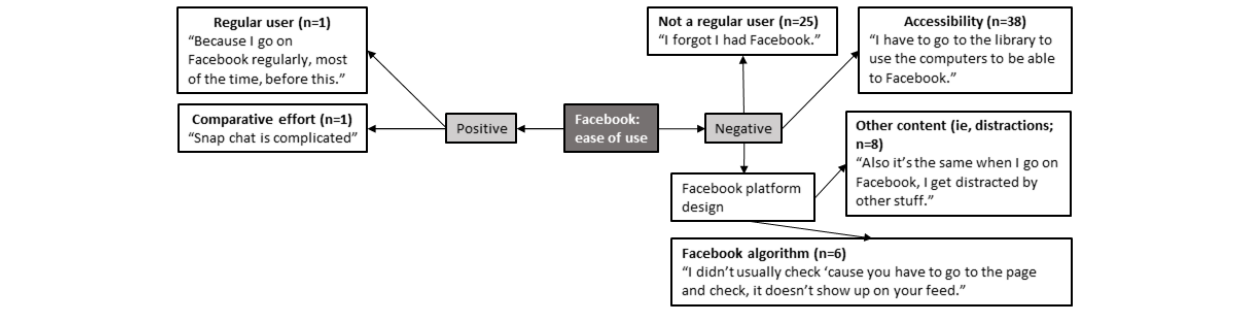
Figure 5. Perceived ease of use of Facebook in adolescents. Note: n=number of times theme was mentioned by